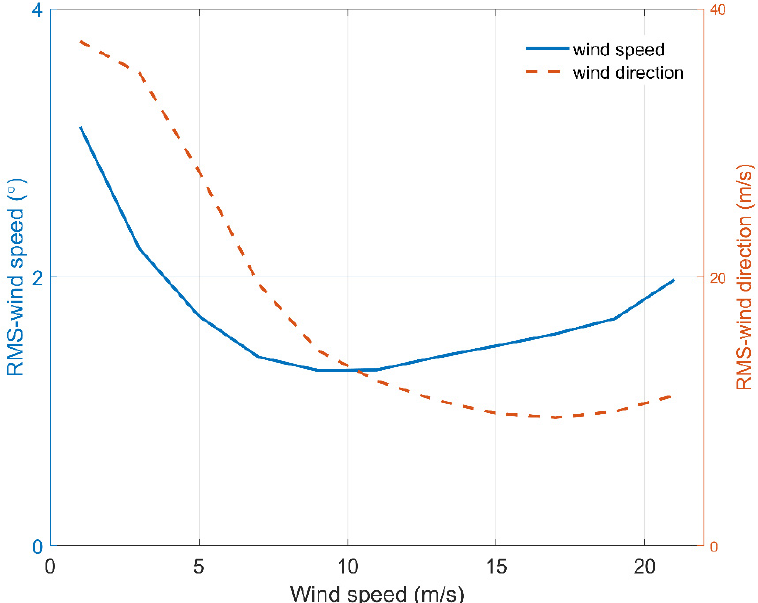
Figure 12. RMS error of HY-2B-ECMWF wind vector as a function of the ECMWF wind speed. The solid and dashed lines represent the results of wind speed and wind direction, respectively.